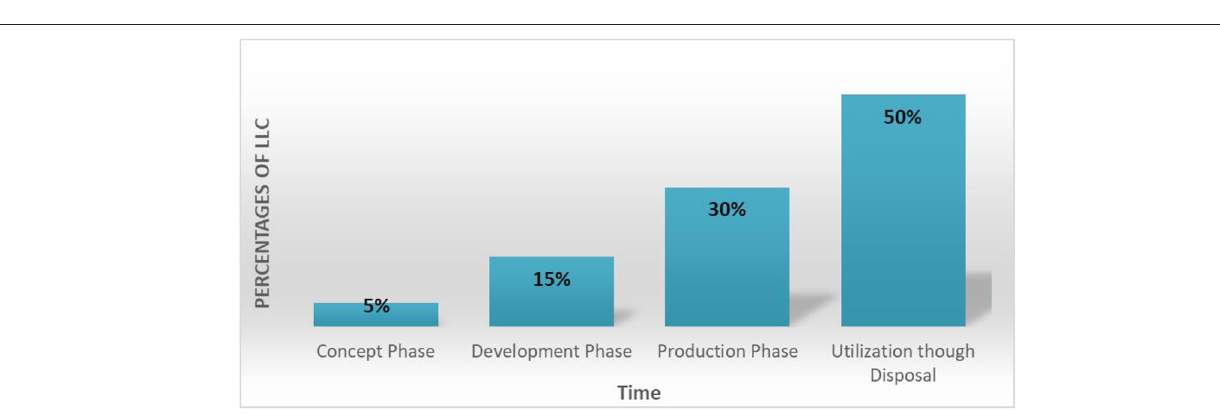
FIGURE 16 | Percentages of life cycle cost with time for proposed system